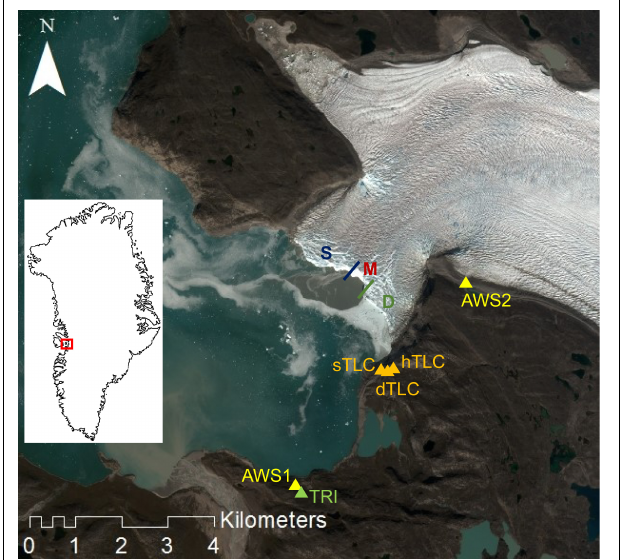
FIGURE 1 | Overview of the field site at Eqip Sermia at the western margin of the Greenland ice sheet. The calving front can be separated in a shallow (S), a middle (M), and a deep sector (D). Background: Sentinel-2A scene from 3 August 2016 (from ESA Copernicus Science Hub: https://scihub.copernicus.eu). The positions of the terrestrial radar interferometer (TRI), the time-lapse cameras (hTLC, dTLC, sTLC) and the two weather stations (AWS1, AWS2) are indicated by